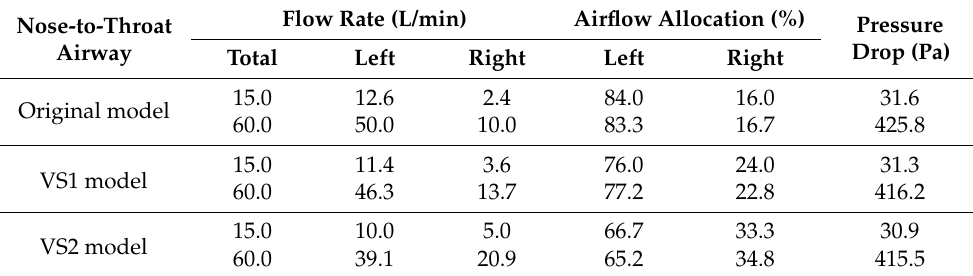
Table 1. Flow rate distributions in the nasal